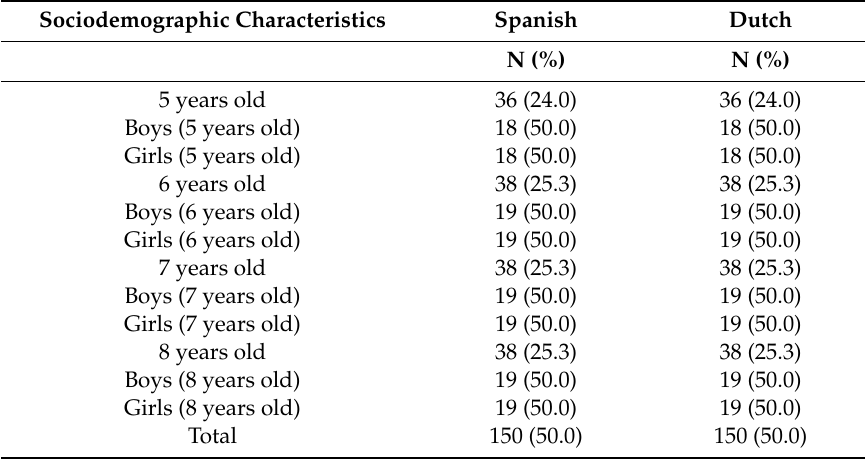
Table A2. Sociodemographic characteristics of the sample ( n =